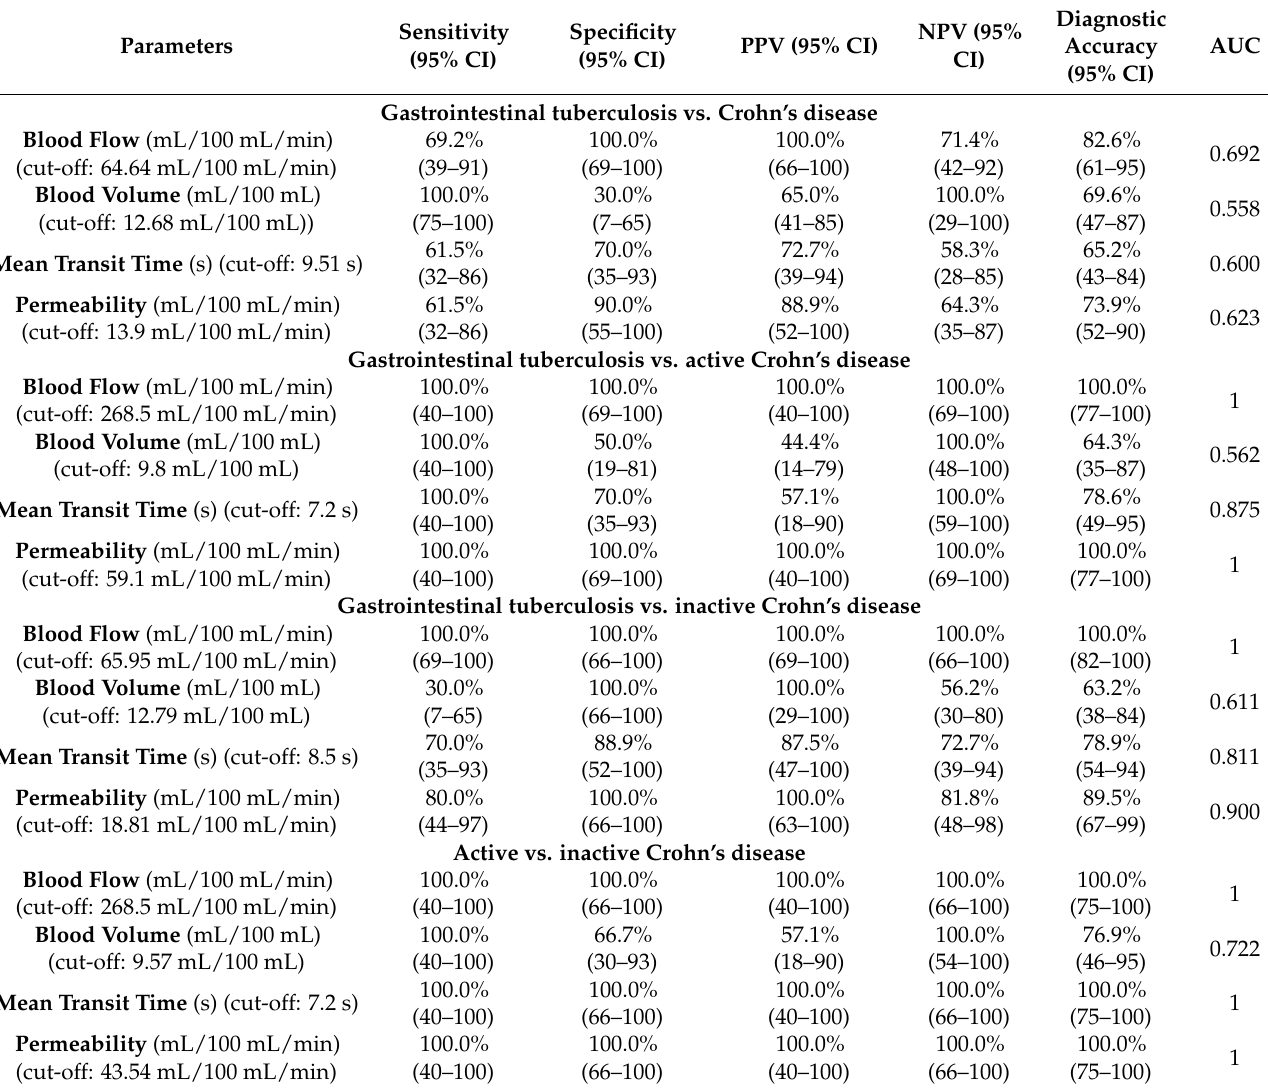
Table 2. Diagnostic performance of perfusion CT parameters between